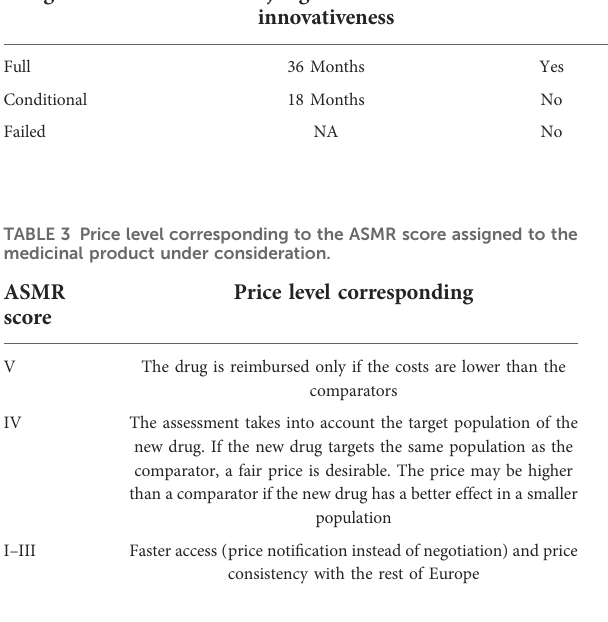
TABLE 2 Description of the characteristics associated with the AIFA innovative judgment assigned to the medicinal product. Innovativeness recognition